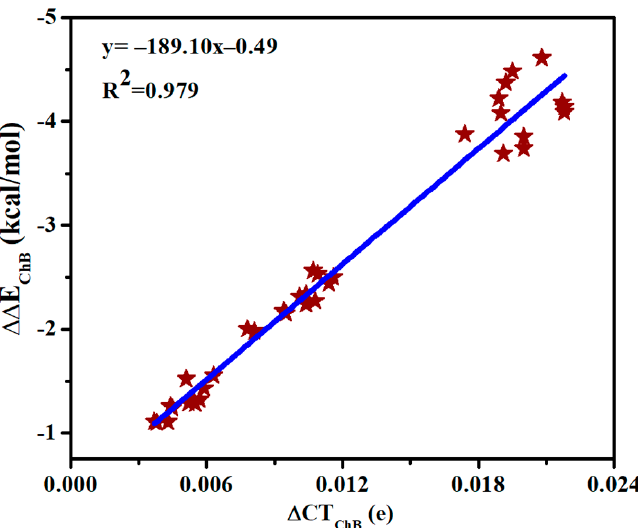
Figure 6. Relationship between increase of both charge transfer ( ∆ CT) and interaction energy ( ∆∆ E) in the chalcogen bonds.